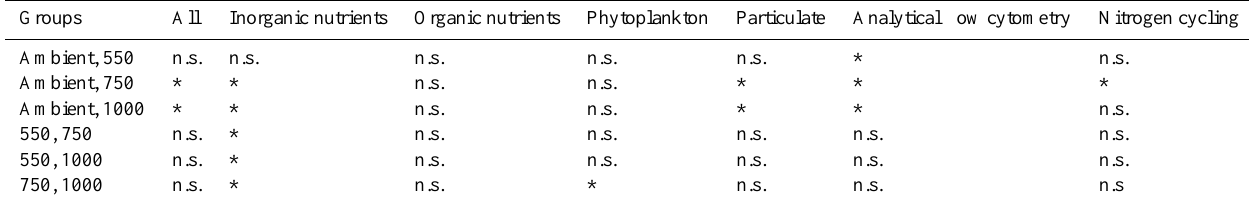
Table 4. Summary of results from pairwise tests for differences among levels of treatment, from permutation-based analysis of variance tests for differences among groups using Type 1 sums of squares based on 999 permutations of residuals under a reduced model. Details of the parameters included in parameter groups are provided in Table 2.